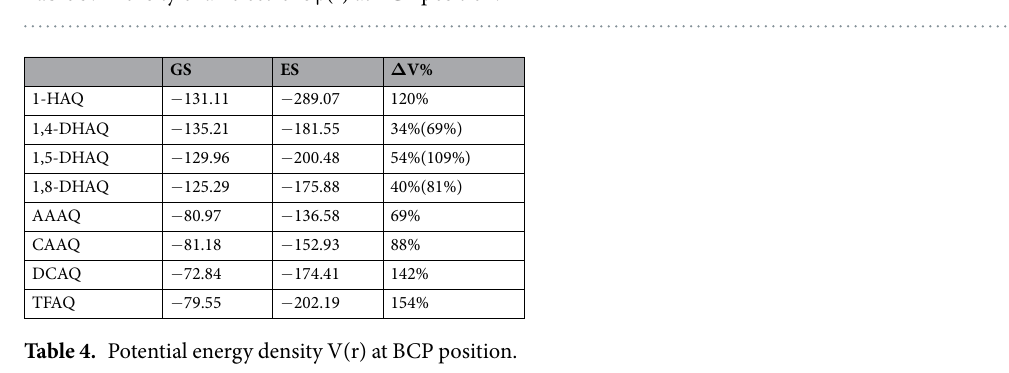
Table 3. Density of all electrons ρ (r) at BCP position.